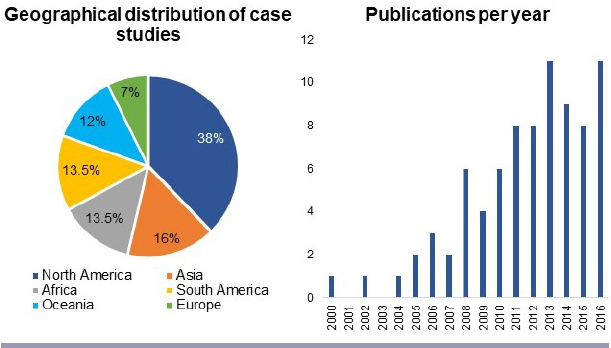
Fig. 2 . Geographical distribution of case studies (n = 82, because one paper investigated two case studies) and temporal distribution of publications (n = 81).